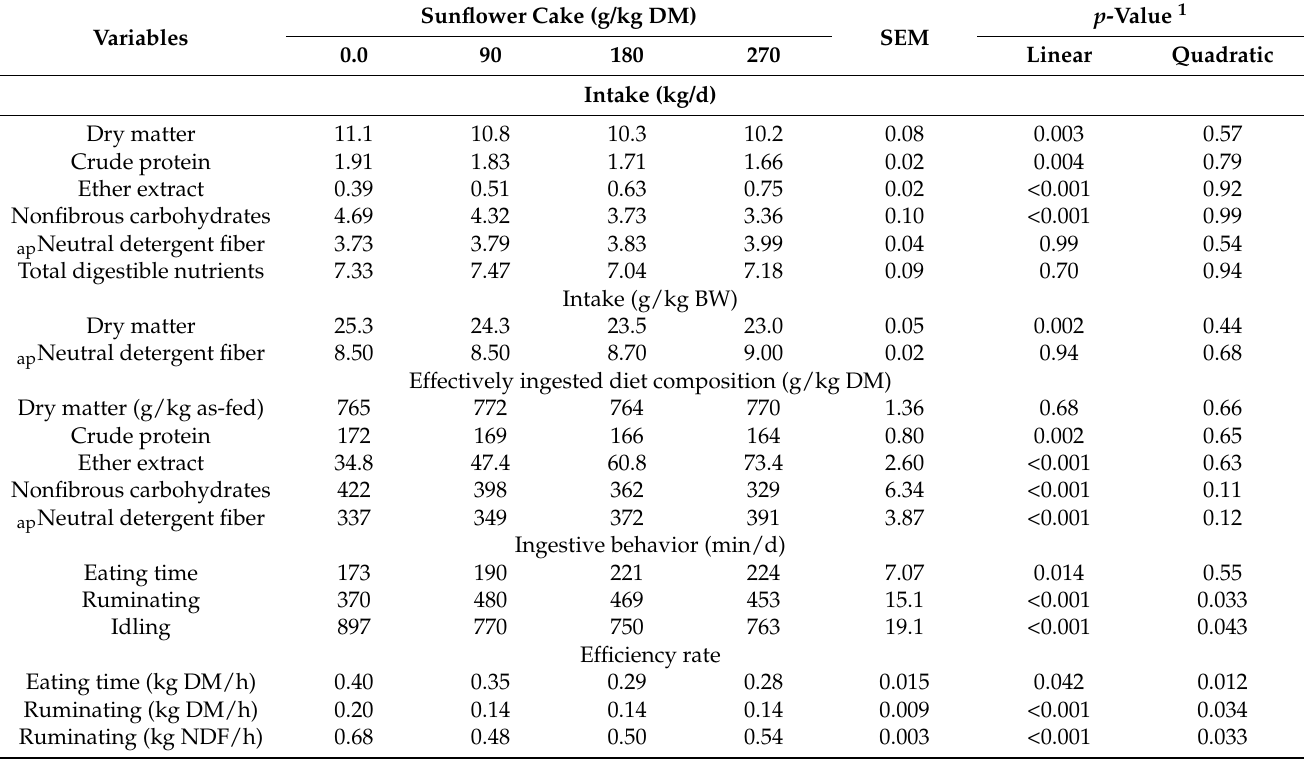
Table 3. Intake, effectively ingested diet composition, and ingestive behavior of young bulls fed diets containing sunflower cake.